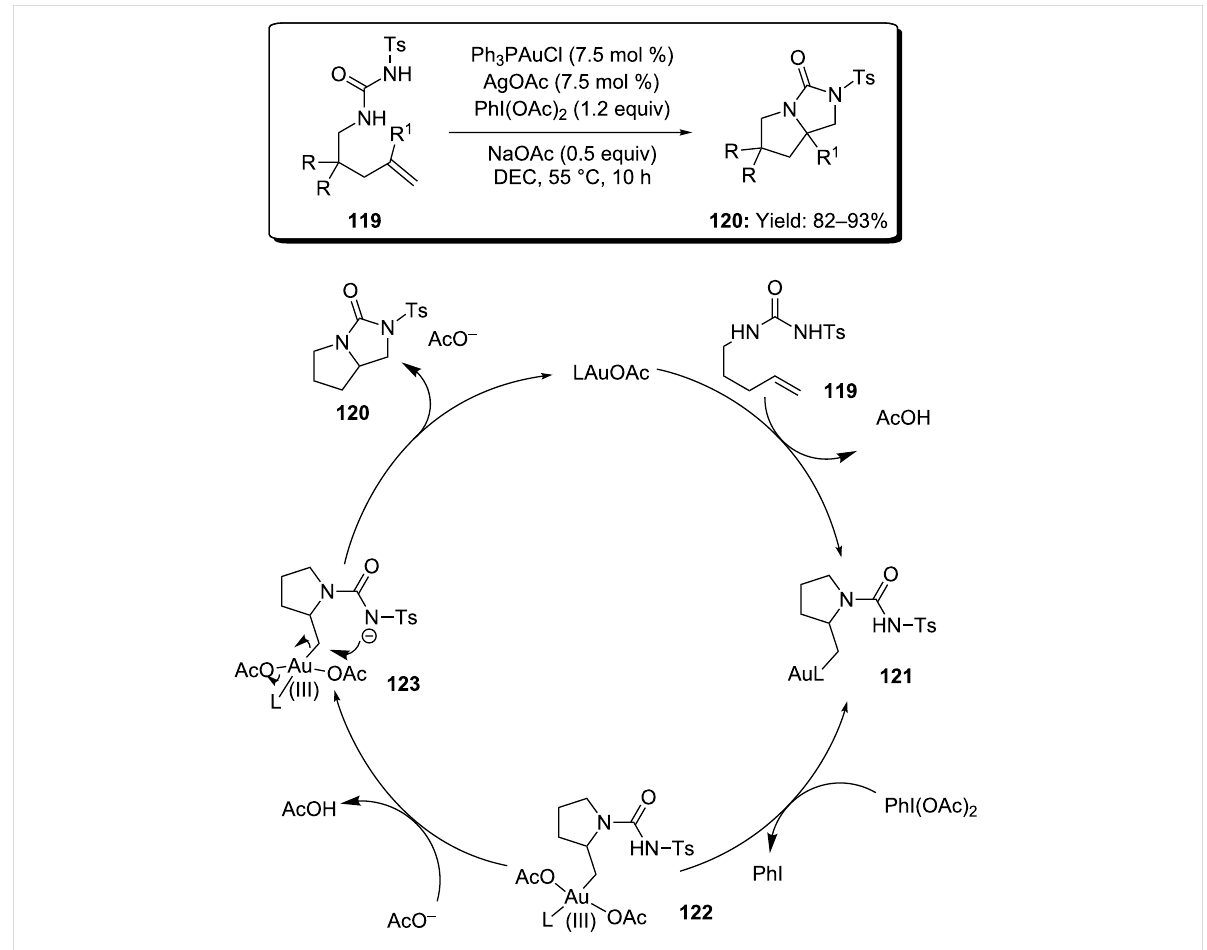
Scheme 31: Gold-catalyzed intramolecular diamination of